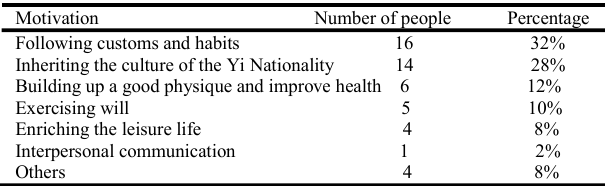
Table 3-2 Analysis of the investigation of the motivation of